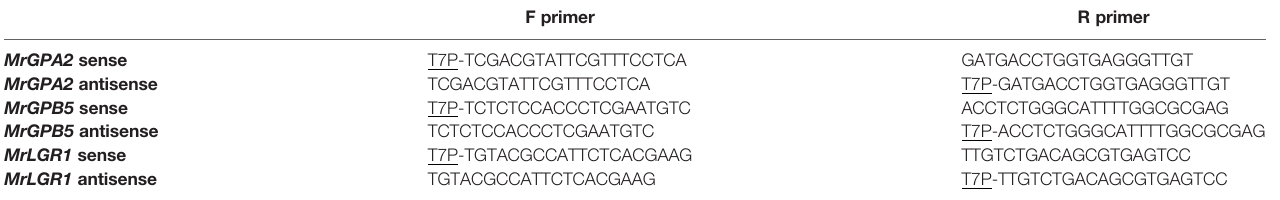
TABLE 3 | Gene-speci fi c primers with T7 promoter site at the 5 ’ of one primer used as templates for dsRNA synthesis.